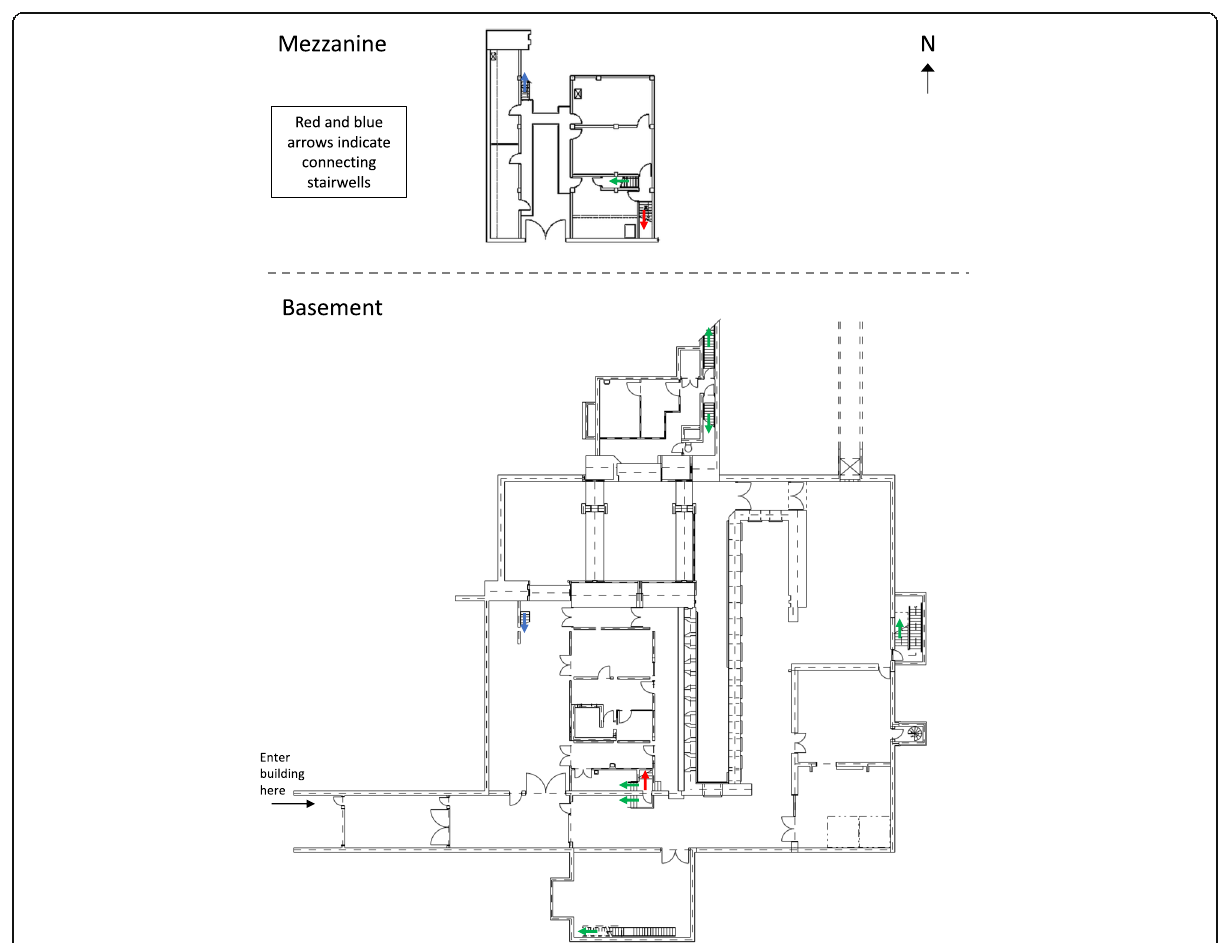
Fig. 2 Study map for simple map carry and simple map study conditions, as seen by